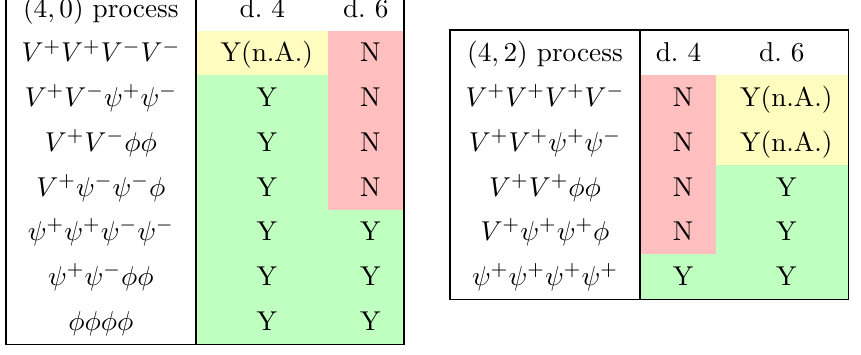
Table 1 . A list of the ( n; h ) = (4 ; 0) and (4 ; 2) processes, whether they contain dimension 4 (d. 4) and dimension 6 (d. 6) pieces, and whether this occurs exclusively for non-Abelian vectors